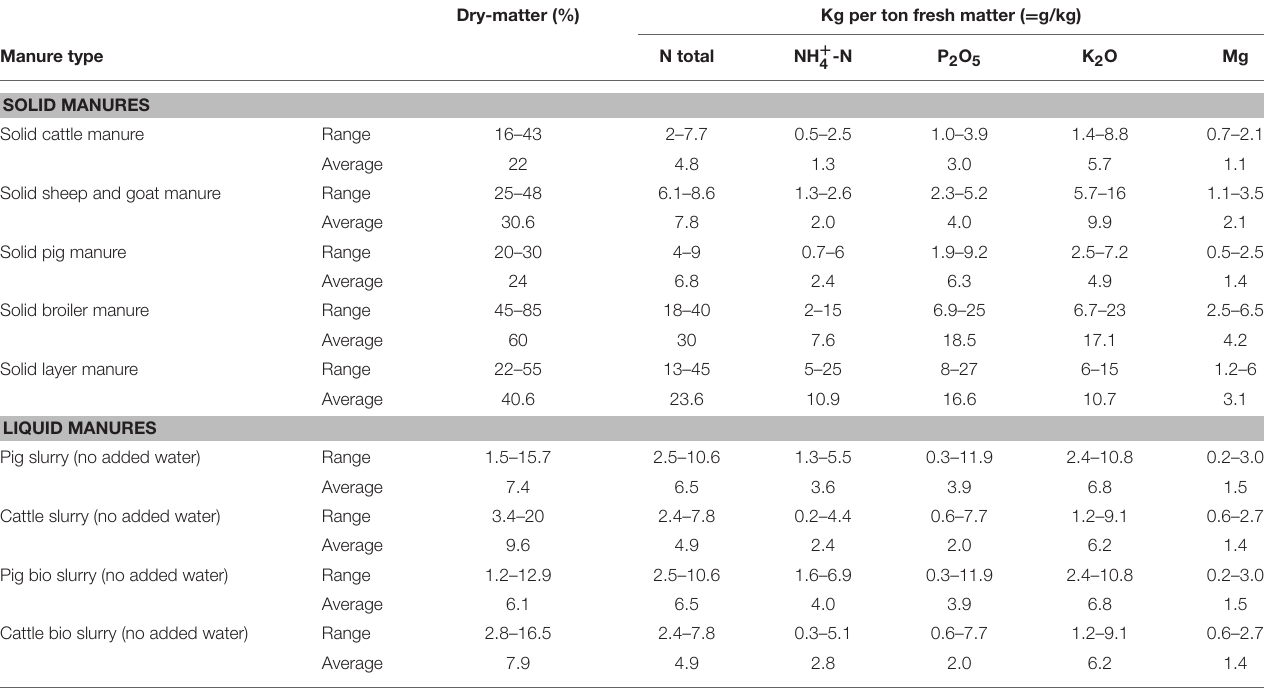
TABLE 4 | Nutrient quality of solid and liquid manures (g/kg) from various animal species expressed as a range and as an average proportion of nitrogen, phosphorus and potassium.